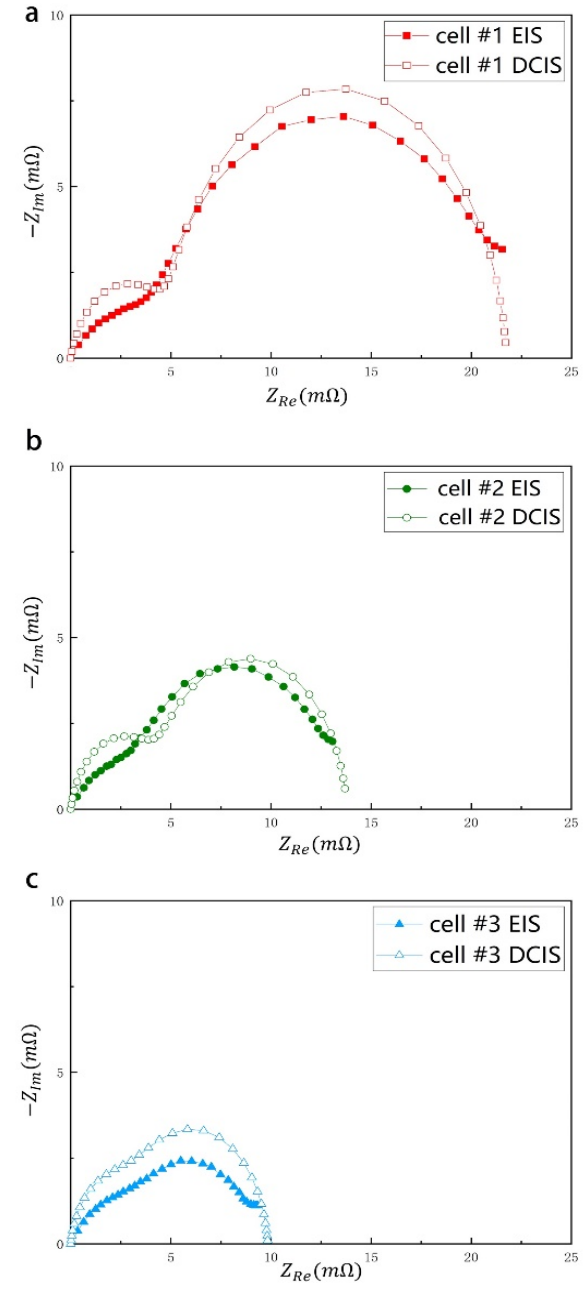
Figure 6. Nyquist plot of EIS measurement (solid dotted) and DCIS calculation (hollow dotted) for ( a ) cell #1 (2650 mAh), ( b ) cell #2 (2850 mAh) and ( c ) cell #3 (3050 mAh).